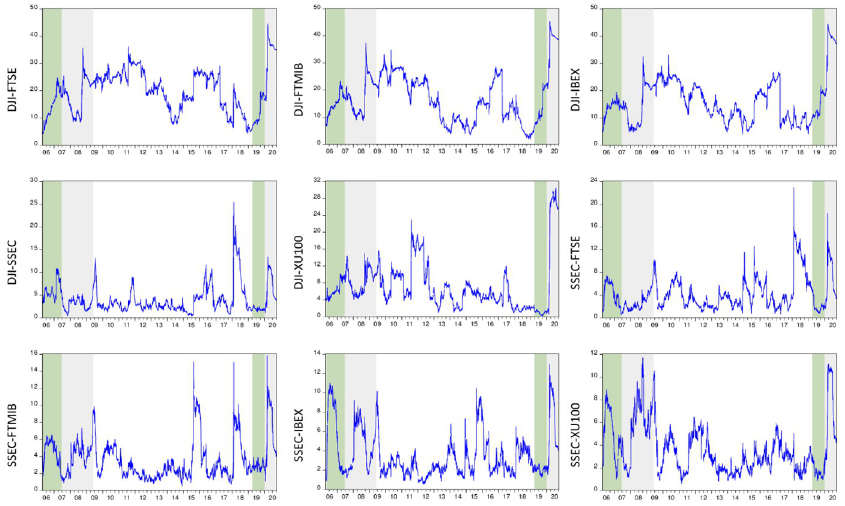
Fig 3. Total volatility spillovers in stock markets (Diebold-Yilmaz method). Green and gray areas demonstrate the pre-crisis and crisis periods, respectively.